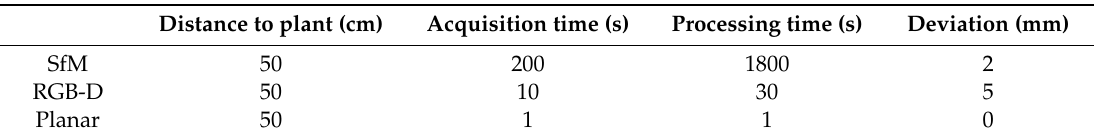
Table 1. Approximation of time-accuracy for the studied methods. The presented values show an average of the models and the averaged values obtained during the process.